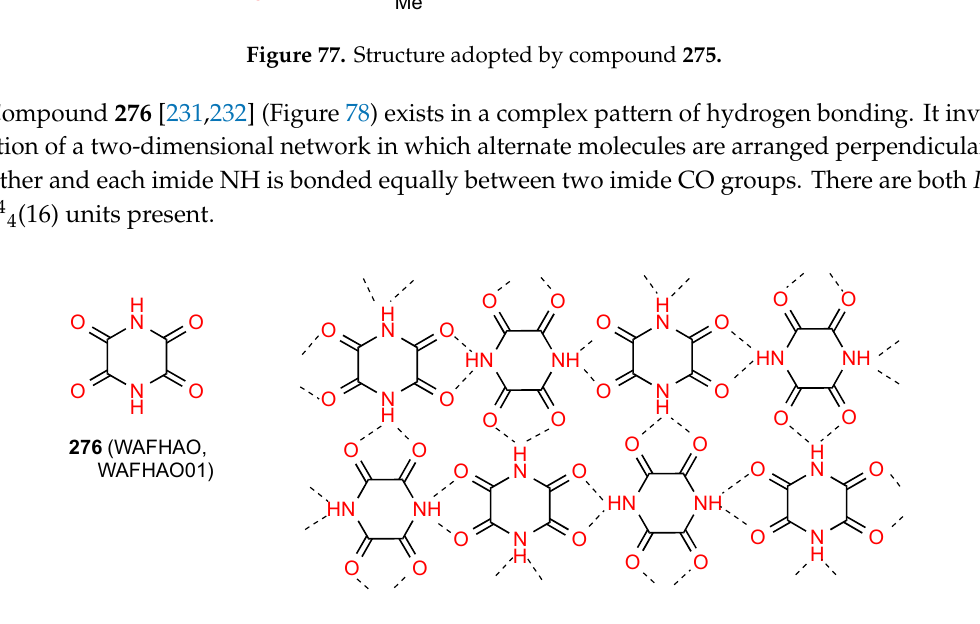
Figure 78. Structure adopted by compound 276.